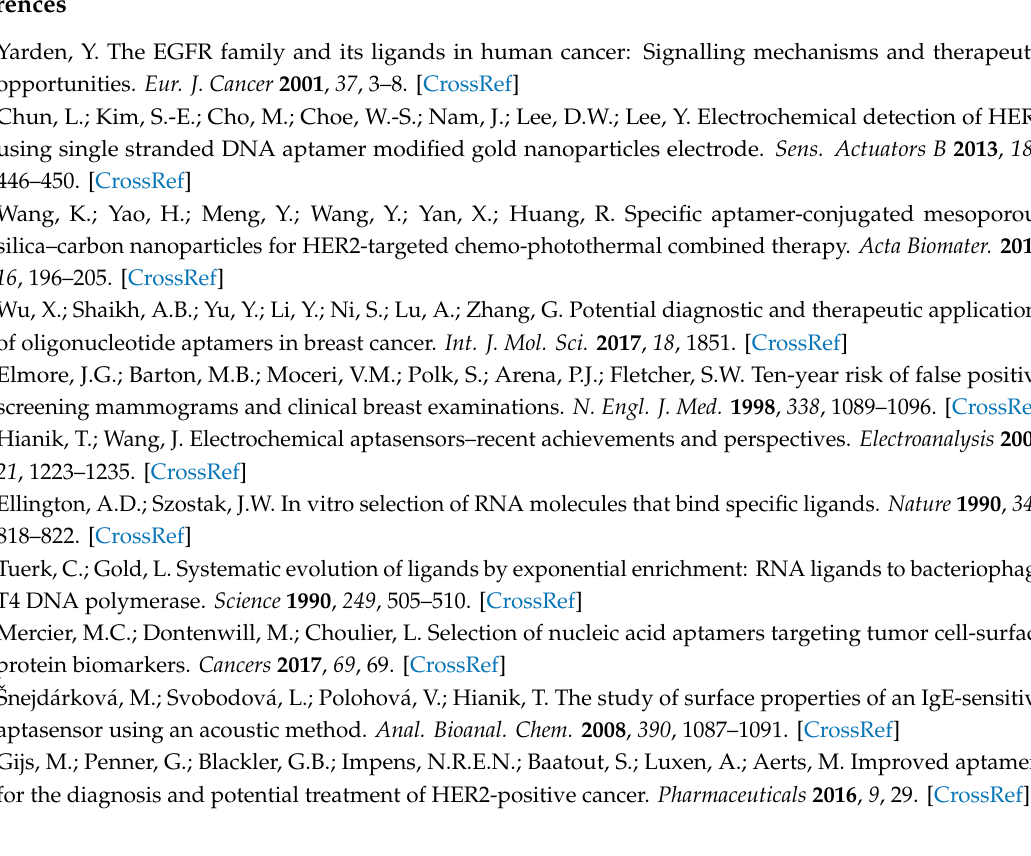
Figure S1: The kinetics of the changes of the series resonant frequency, ∆ f s , (curve 1) and motional resistance, ∆ R m , (curve 2) of TSM transducer following addition of neutravidin (NA) (125 µ g / mL), HeA2_3 aptamers (0.5 µ M) and SK-BR-3 cells (A) or MDA-MB-231 cells (B). The concentration of the cells was 5 × 10 5 cells / mL. The arrows indicate addition of respective compounds as well as the washing of the surface by water, PBS or by PBS with addition of aliquot volume of DMEM (PBS*), Figure S2: The kinetics of the changes of the series resonant frequency, ∆ f ∆ R s , (curve 1) and motional resistance, m , (curve 2) of TSM transducer following addition of neutravidin (NA) (125 µ g / mL), sgc8c aptamers (0.5 µ M) and SK-BR-3 cells (A) or MDA-MB-231 cells (B). The concentration of the cells was 5 × 10 5 cells / mL. The arrows indicate addition of various compounds and the washing of the surface by water, PBS and by PBS with addition of aliquot volume of DMEM (PBS*), Figure S3: The kinetics of the changes of the series resonant frequency, ∆ f s , (curve 1) and motional resistance, ∆ R m , (curve 2) of TSM transducer following addition of neutravidin (NA) (125 µ g / mL) and SK-BR-3 cells in a concentration of 5 × 10 5 cells / mL. The arrows indicate addition of various compounds and the washing of the surface by water, PBS and by PBS with addition of aliquot volume of DMEM (PBS*), Figure S4: AFM topography of the surface of TSM transducer and the height profiles at marked part of the images for freshly cleaned gold layer (a,c) and for neutravidin immobilized at the gold layer (b,d). The scan size is 5 × 5 µ m, Figure S5: AFM topography of the neutravidin layer at gold after application of mechanical scratching (left) and the height profile at the marked site (right). The scan size is 6 × 6 µ